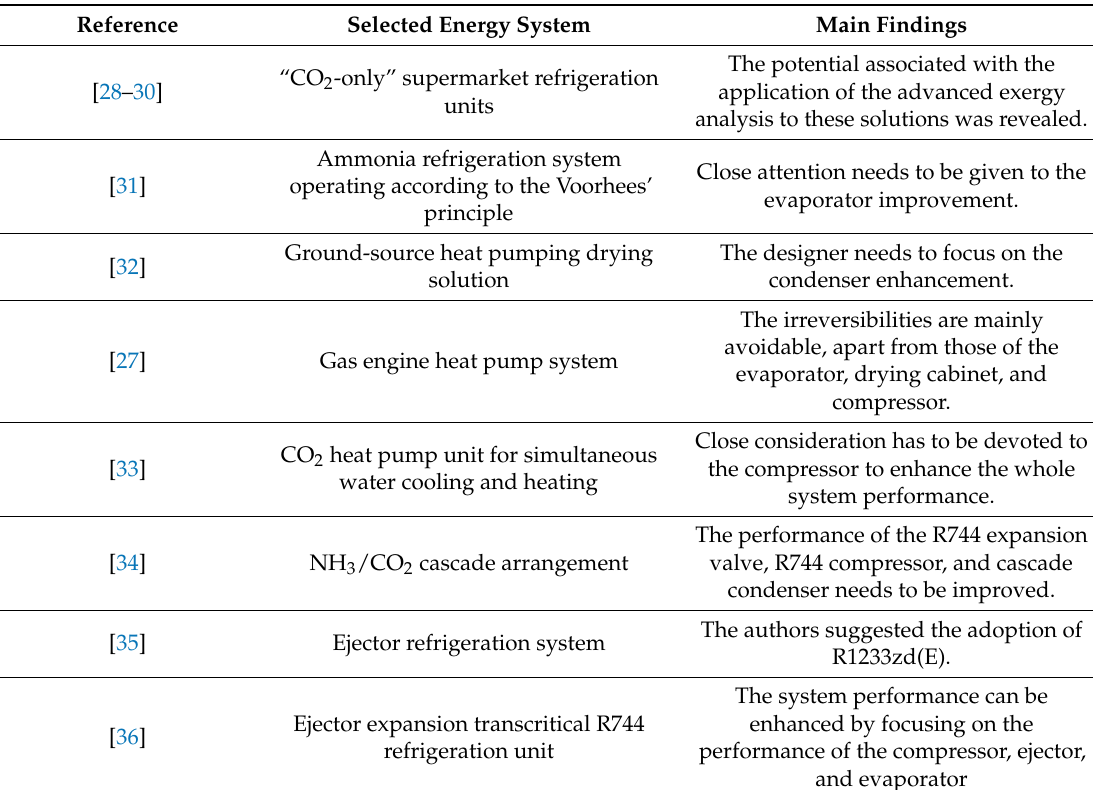
Table 2. Findings of the main investigations associated with the advanced exergy analysis applied to vapor-compression